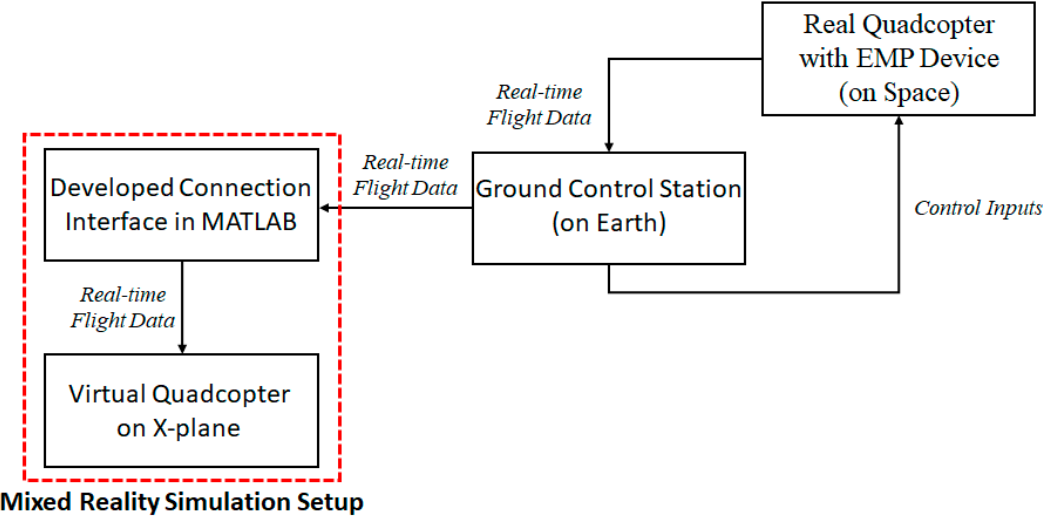
Figure 16. Overview of the mixed reality simulation for the quadcopter space activates using a dual ‐ head EMP device.